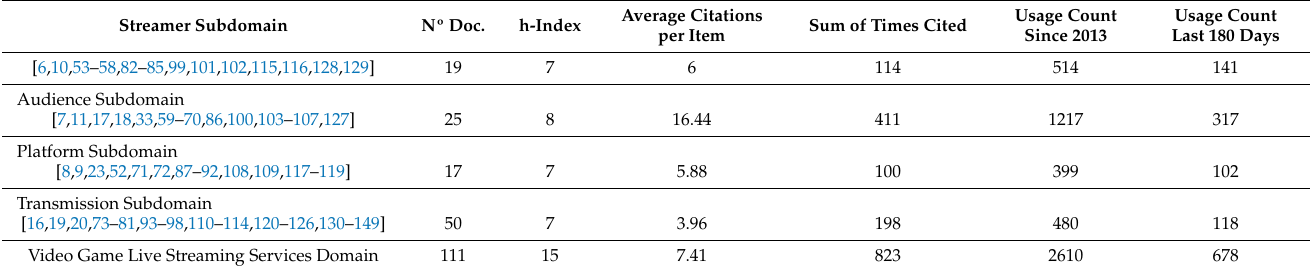
Table 3. Main bibliometric indicators for the analyzed